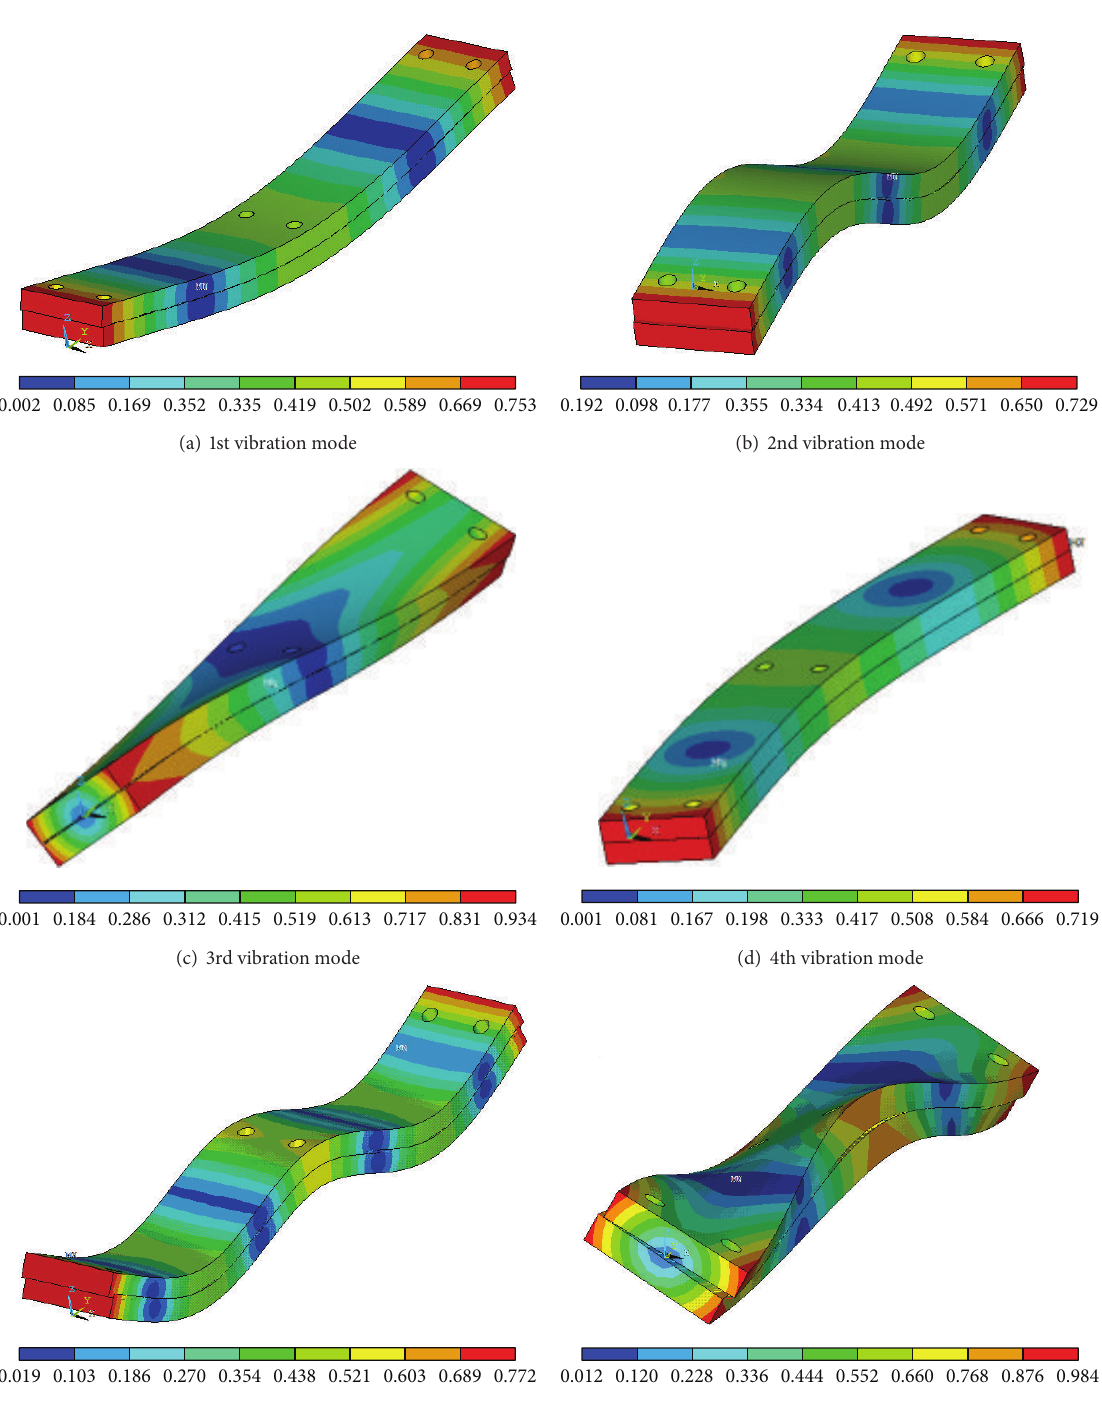
Figure 14: Model analysis